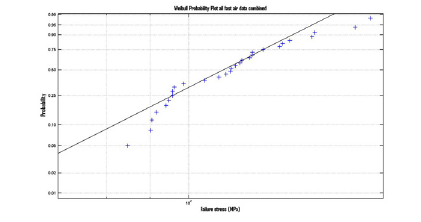
Figure 3: Weibull plots of the three series of fast air tests.